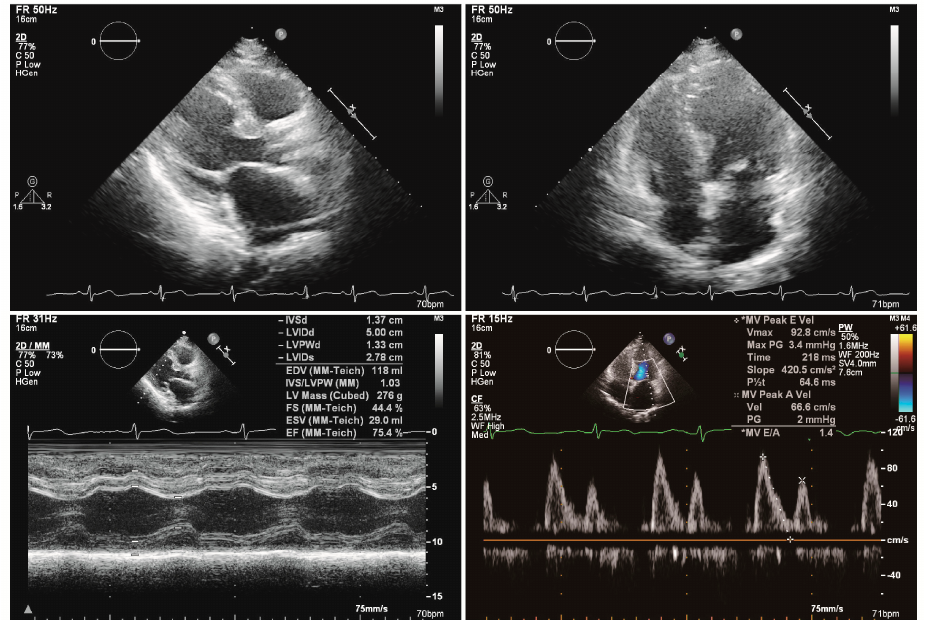
Figure 2. The cardiac ultrasound showed normal wall motion with a left ventricular ejection fraction of 75.4%. There was no significant valvular disorder.